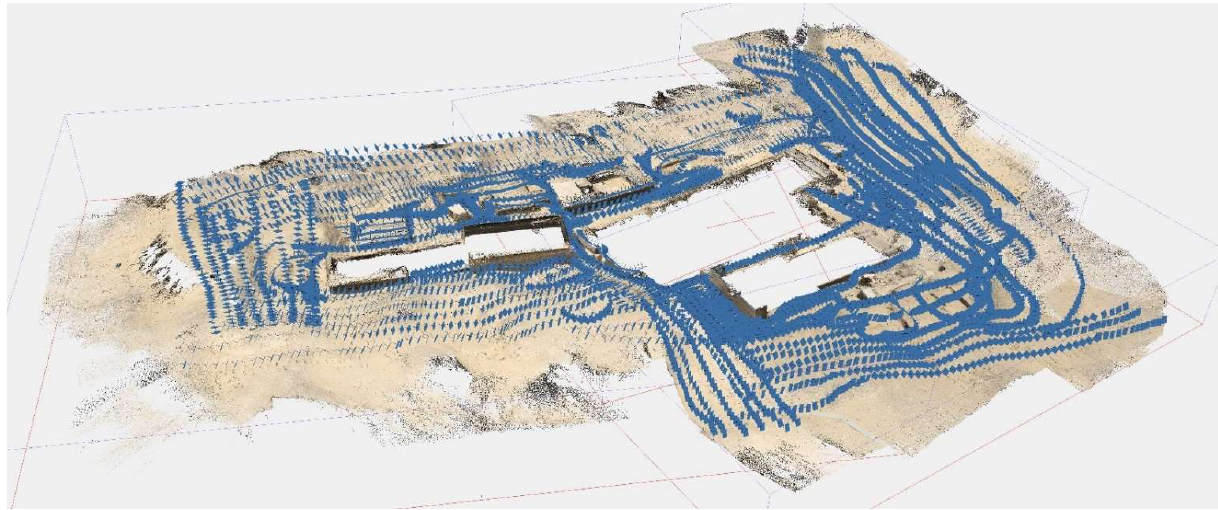
Figure 1. Image network carried out to survey the DTM on the concession of the Dutch-Italian mission to